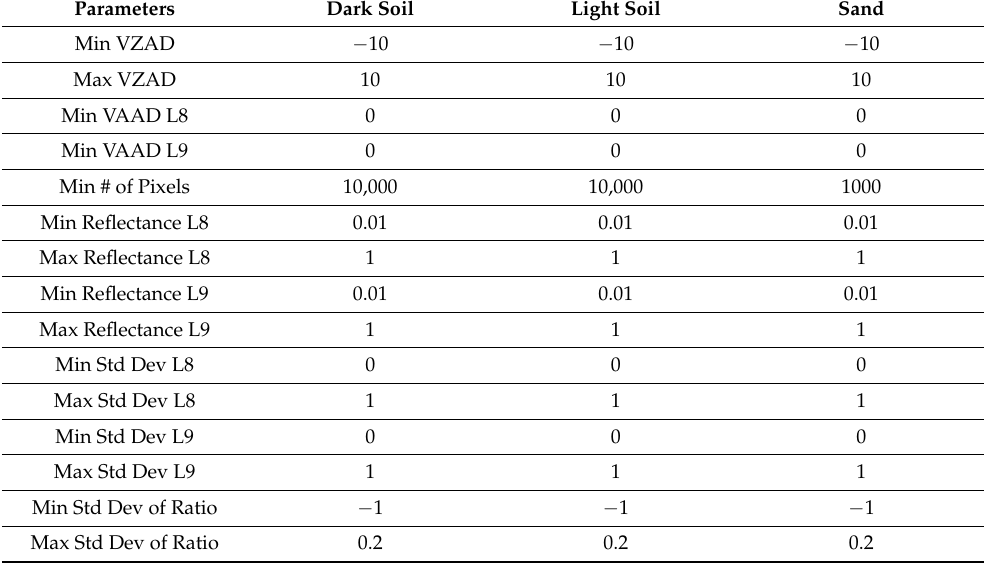
Table A2. Barren-filtering algorithm